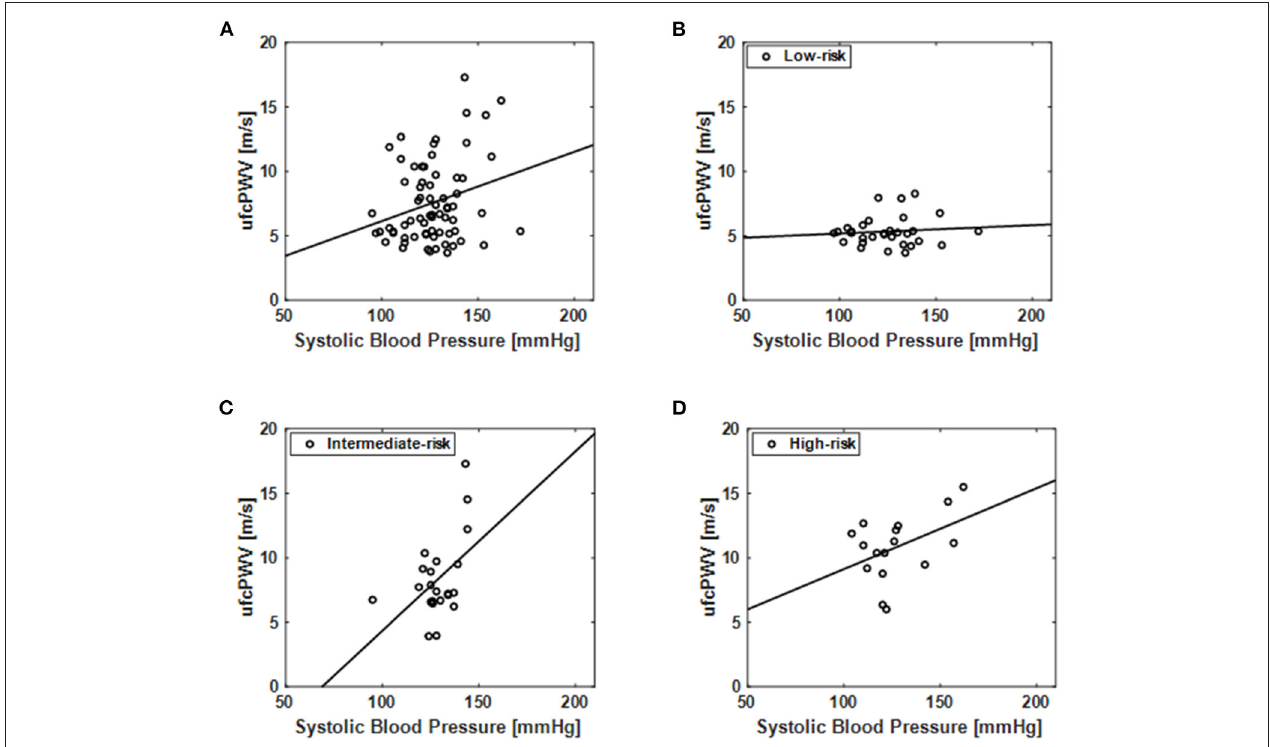
FIGURE 4 | Correlation of the ufcPWV based on ultrafast curved array imaging with systolic blood pressure ( Table 1 ) for (A) all subjects ( n = 69) and individual CV risk groups [ (B) low-, (C) intermediate- and (D)